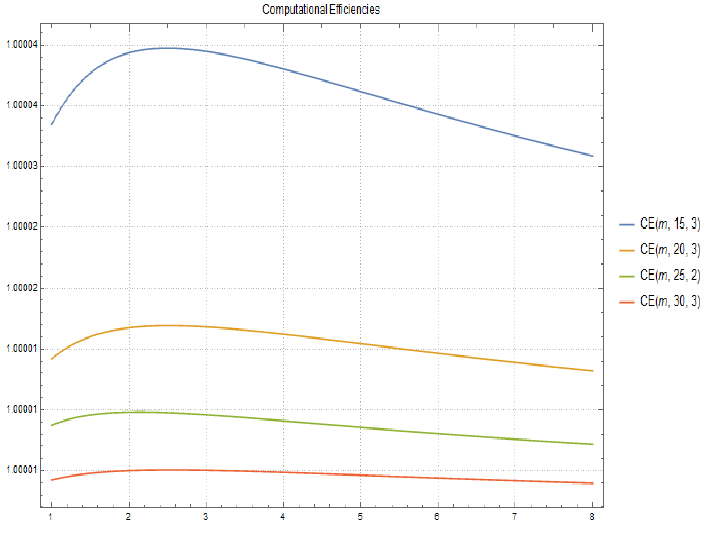
Figure 2. Computational Efficiencies for p = 2 and different values of q and m